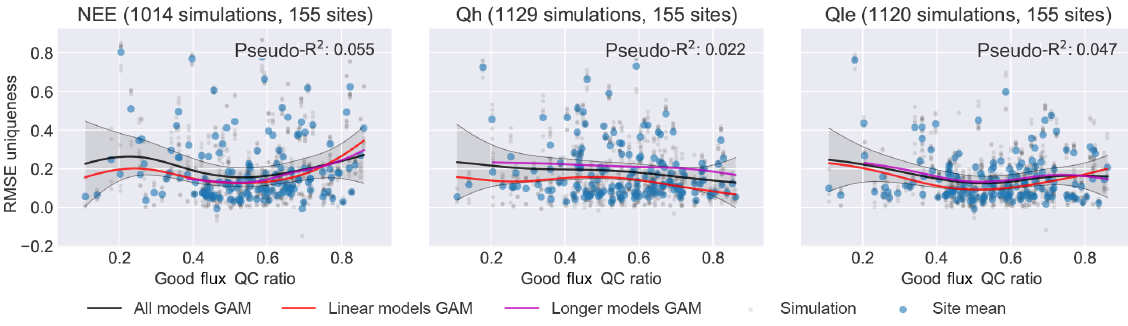
AR-SLu AR-Vir AT-Neu AU-ASM AU-Ade AU-Cpr AU-Cum AU-DaP AU-DaS AU-Dry AU-Emr AU-Fog AU-GWW AU-Gin AU-How AU-Lox AU-RDF AU-Rig AU-Rob AU-Stp AU-TTE AU-Wac AU-Whr EE Q h e Q l N Figure 10. RMSE uniqueness mean across models for each flux at each site in alphabetical order. Darker colours indicate more unique sites for each